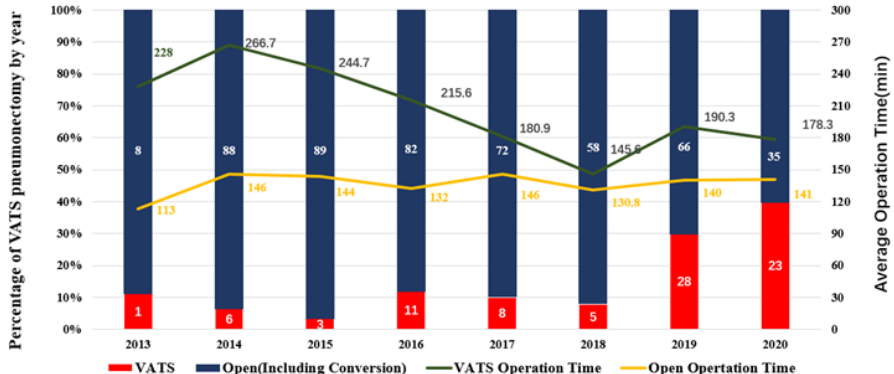
Figure 1. Changes in percentage of VATS pneumonectomy and average operation time during 2013 – 2020. The height of the red column represents the percentage of VATS pneumonectomy. The yellow curve represents the average time of Open pneumonectomy, while the green curve represents the mean time of VATS pneumonectomy.